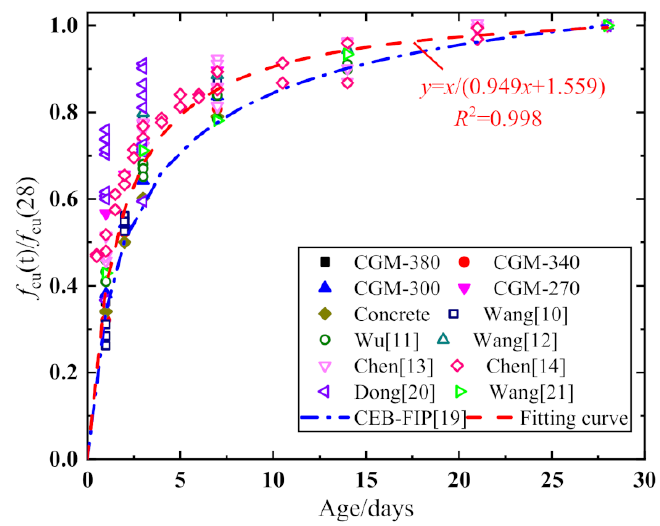
Figure 3. Variations of cubic compressive strength with respect to testing